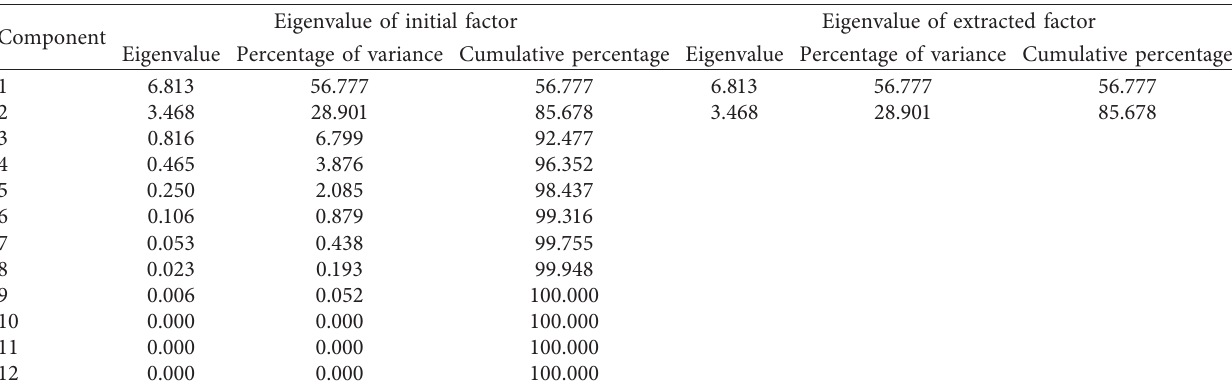
Figure 2: Scree plot of principal component analysis. Table 5: List of principal